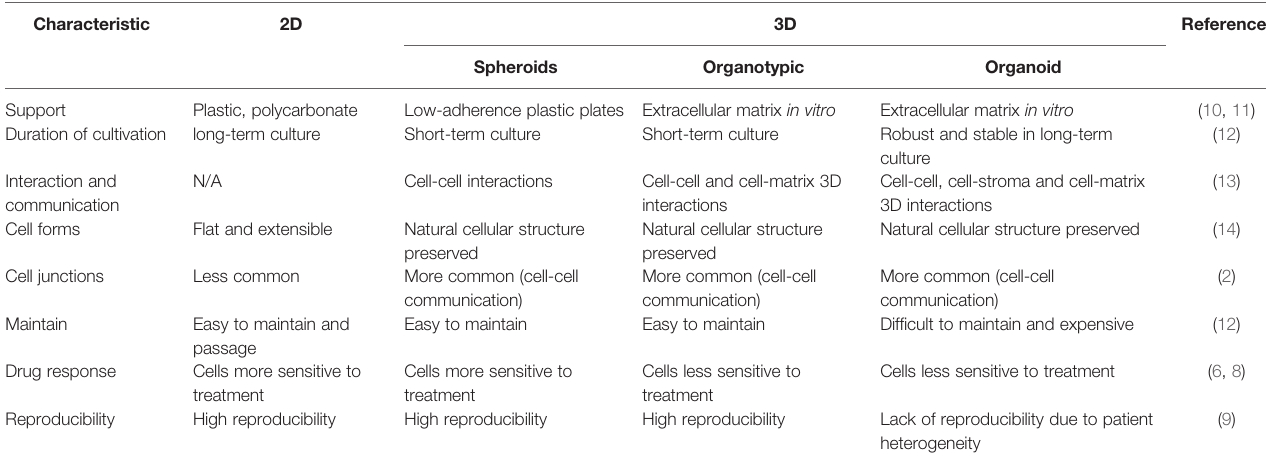
TABLE 1 | Advantages and disadvantages of using 3D versus 2D